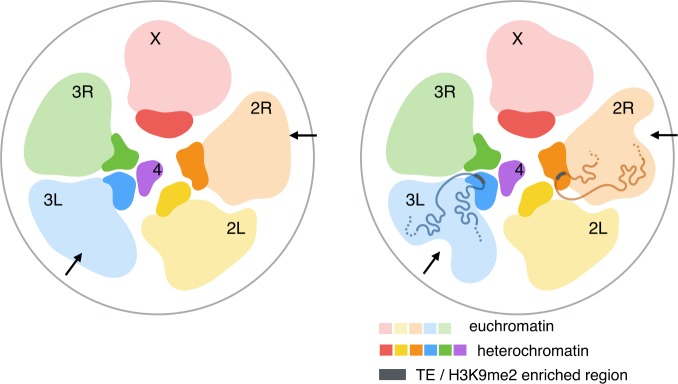
Proposed spatial architecture of D. melanogaster genome.PCH genomic regions located on different chromosomes coalesce to form the 3D PCH domains, or chromocenters. PCH regions (darker color) and the euchromatic genome (lighter color) form their own separate territories. PCH regions on different chromosomes interact, with inter-arm (2L-2R, 3L-3R) and inter-chromosomal 3rd-4th chromosome 3D interactions being more frequent than random expectations. 3D contacts between polymorphic H3K9me2/3-enriched regions in the euchromatic genome (potentially due to TEs, gray bar) and PCH lead to varying 3D genome conformations between individuals (arrows). 3D structures of the euchromatic genome were based on [67] and the positions of PCH regions are inferred from data in Fig 2B.